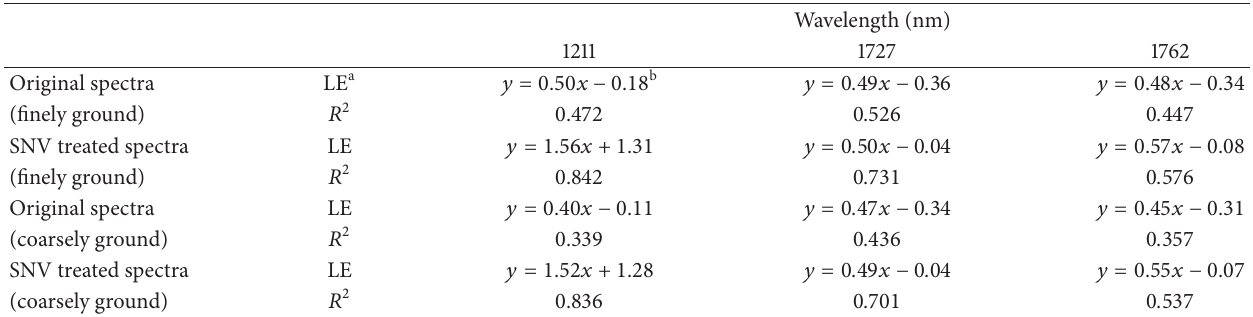
Table 3: Linear relationship between fat content and absorbance intensity at three major peaks of triglycerides for original and mathematical transformed spectra of both finely and coarsely ground FBS sample.